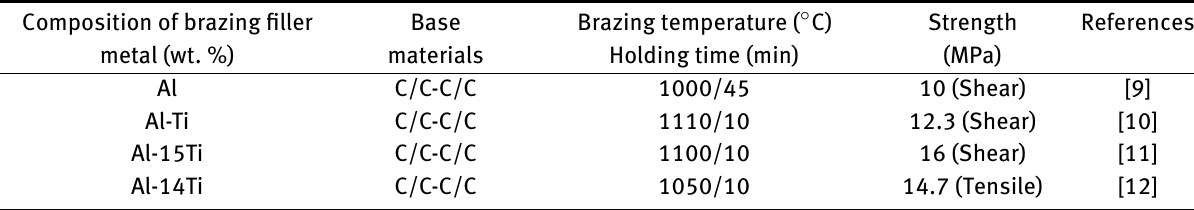
Table 1: Al-based brazing filler metals used in joining of C/C composites Composition of brazing